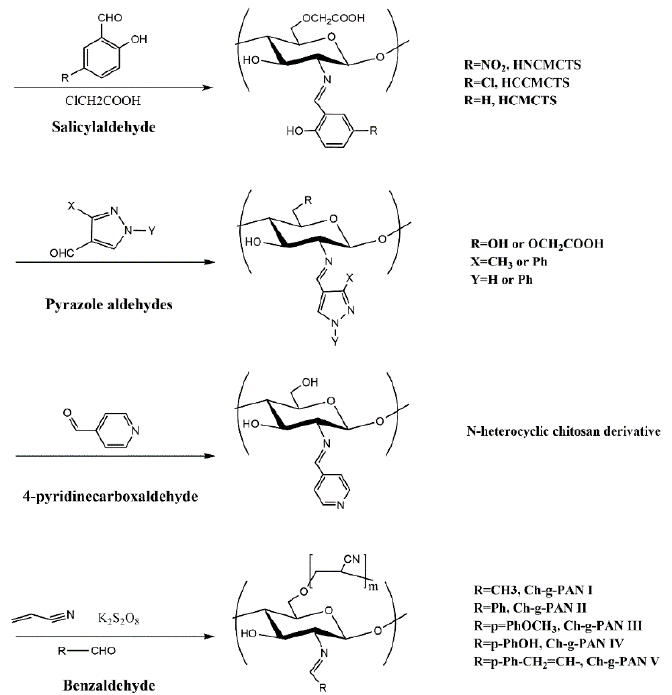
Figure 3. Schiff base derivatives of chitosan modified with active aldehydes or